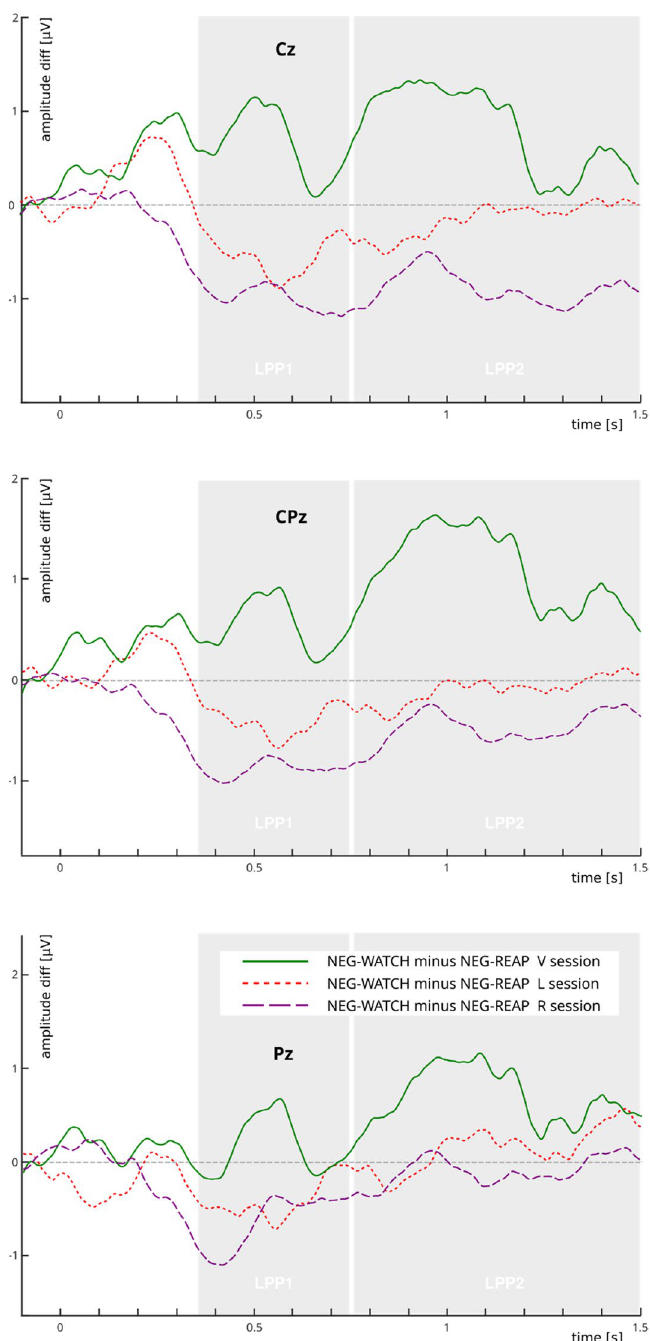
Figure 3. Amplitude differences in grand averages for the NEG-WATCH minus NEG-REAP conditions at electrodes Cz (upper plot), Cpz (middle plot), and Pz (lower plot) after the three TMS sessions (L, R, V). Positive values are associated with a decrease in the LPP amplitude after reappraisal relative to passive watch, which reflects successful emotion downregulation. Shaded gray areas indicate the LPP time-windows submitted to statistical analysis (LPP1: 350–750 ms, LPP2: 750–1500 ms). Time zero on the x-axis indicates picture onset. The x-axis runs from the beginning of the baseline (100 ms prior to picture onset) to 1500 ms after picture